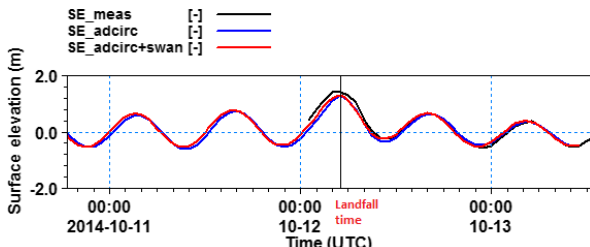
Figure 4. Time series of surface elevation (metres) representing measured surface elevation (red line), SE from ADCIRC alone (blue line) and SE from ADCIRC + SWAN (black line) at Visakhapatnam coast (17.63 ◦ N, 83.26 ◦ E) during 10–13 October